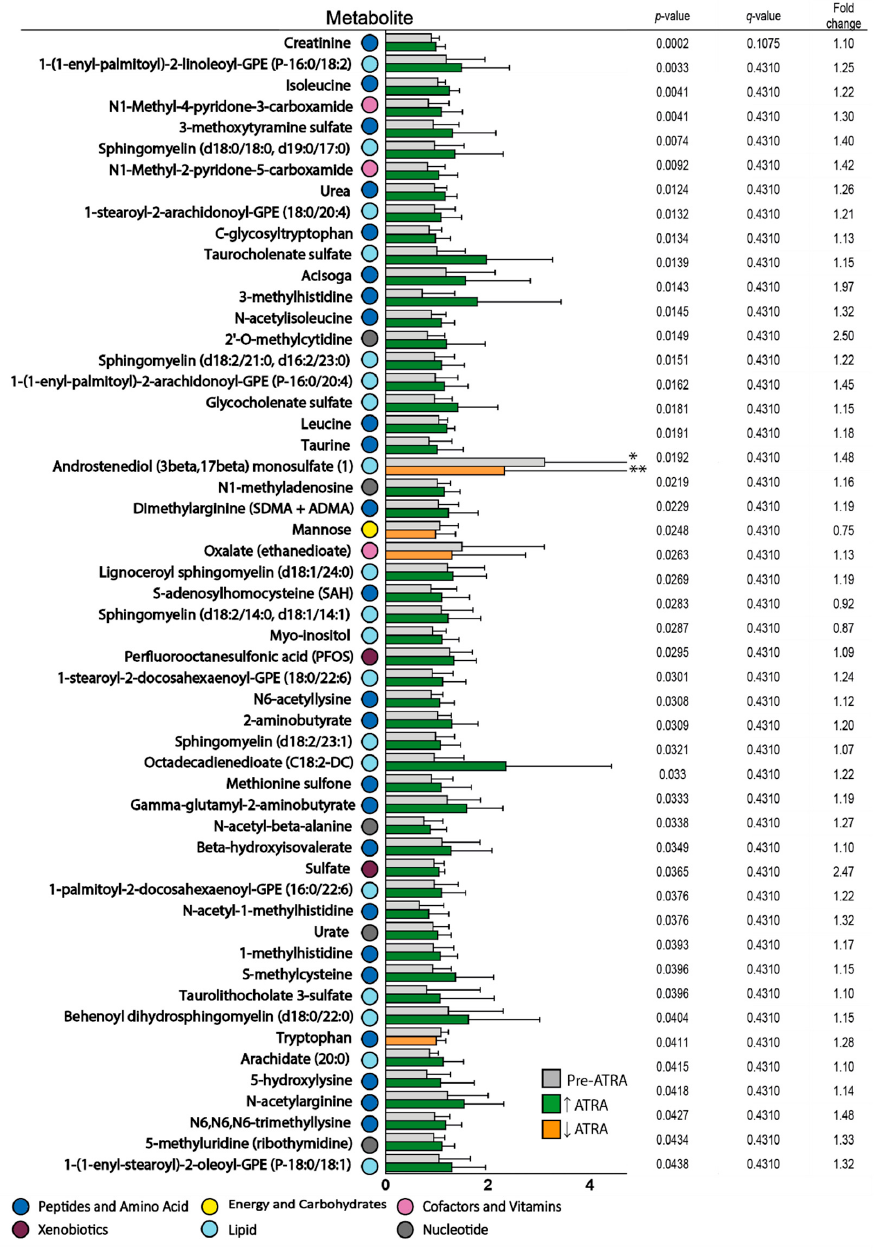
Figure 4. The effect of ATRA monotherapy on the serum metabolomic profiles of patients after two days of treatment. Fifty-four metabolites were significantly altered after ATRA treatment ( p < 0.05). The p -values, q -values, and mean fold change values for each metabolite are listed to the right in the figure (ranked by p -value), and a fold change > 1 indicates that the levels were increased in responders compared with non-responders. Pretherapy levels of serum metabolites for the ten patients are presented in grey, increased levels during ATRA treatment are presented in green and decreased levels presented in yellow. Color codes for classification of metabolites are explained at the bottom of the figure. Error bars show Standard deviation (SD). * Androstenediol (3 beta, 17 beta) pre-ATRA SD 3.862, ** Androstenediol (3 beta,17 beta) post-ATRA SD